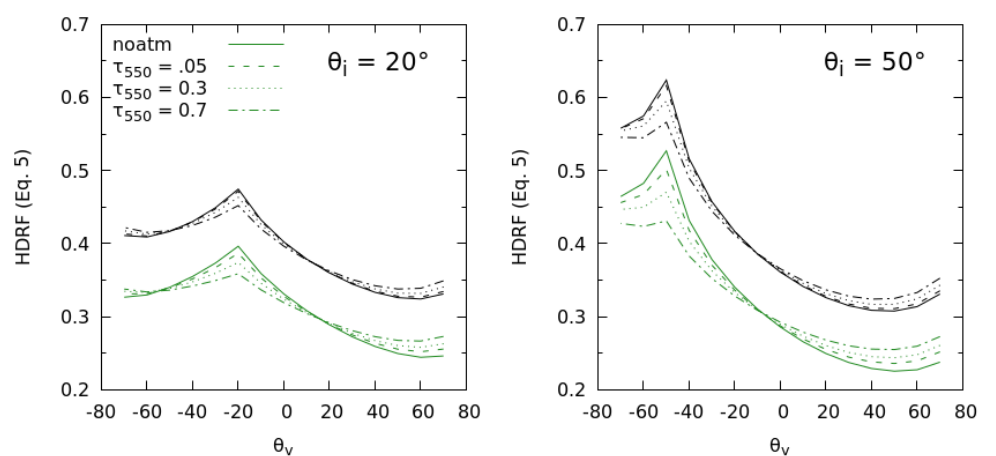
Figure 2. Spectral Hemispherical-Directional Reflectance Factor in the principal plane for sun zenith θ i of 20 ◦ ( left panel ) and 50 ◦ ( right ), for increasing atmospheric turbidity (indicated by increasing τ 550 from 0 to 0.7). Green lines refer to the 0.55 µ m wavelength, black color refers to the NIR (0.87 µ m).